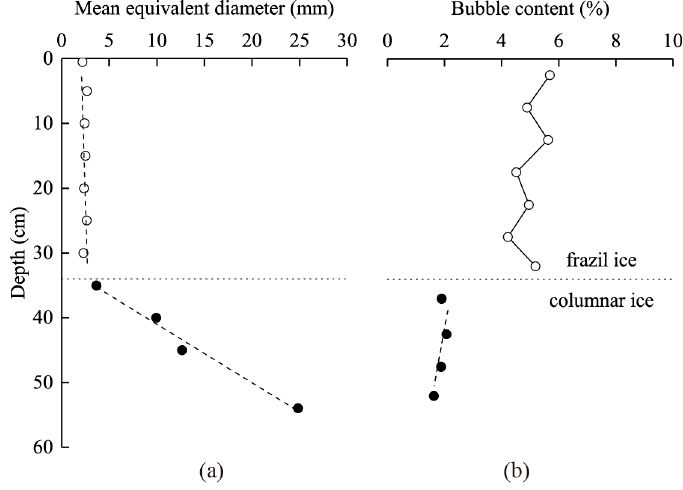
Figure 12. Variation in crystal grain size and bubble content with depth: ( a ) ice crystal grain size; ( b ) bubble content.